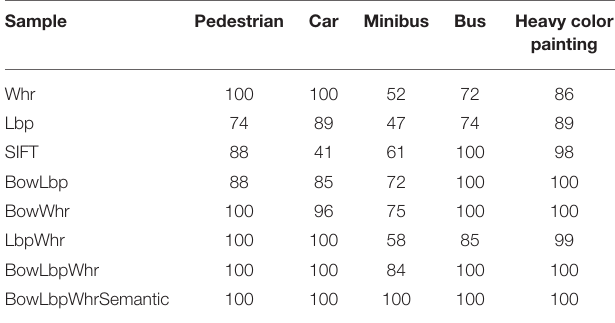
TABLE 3 | The classification result using different classifier on sample set B. Fused feature